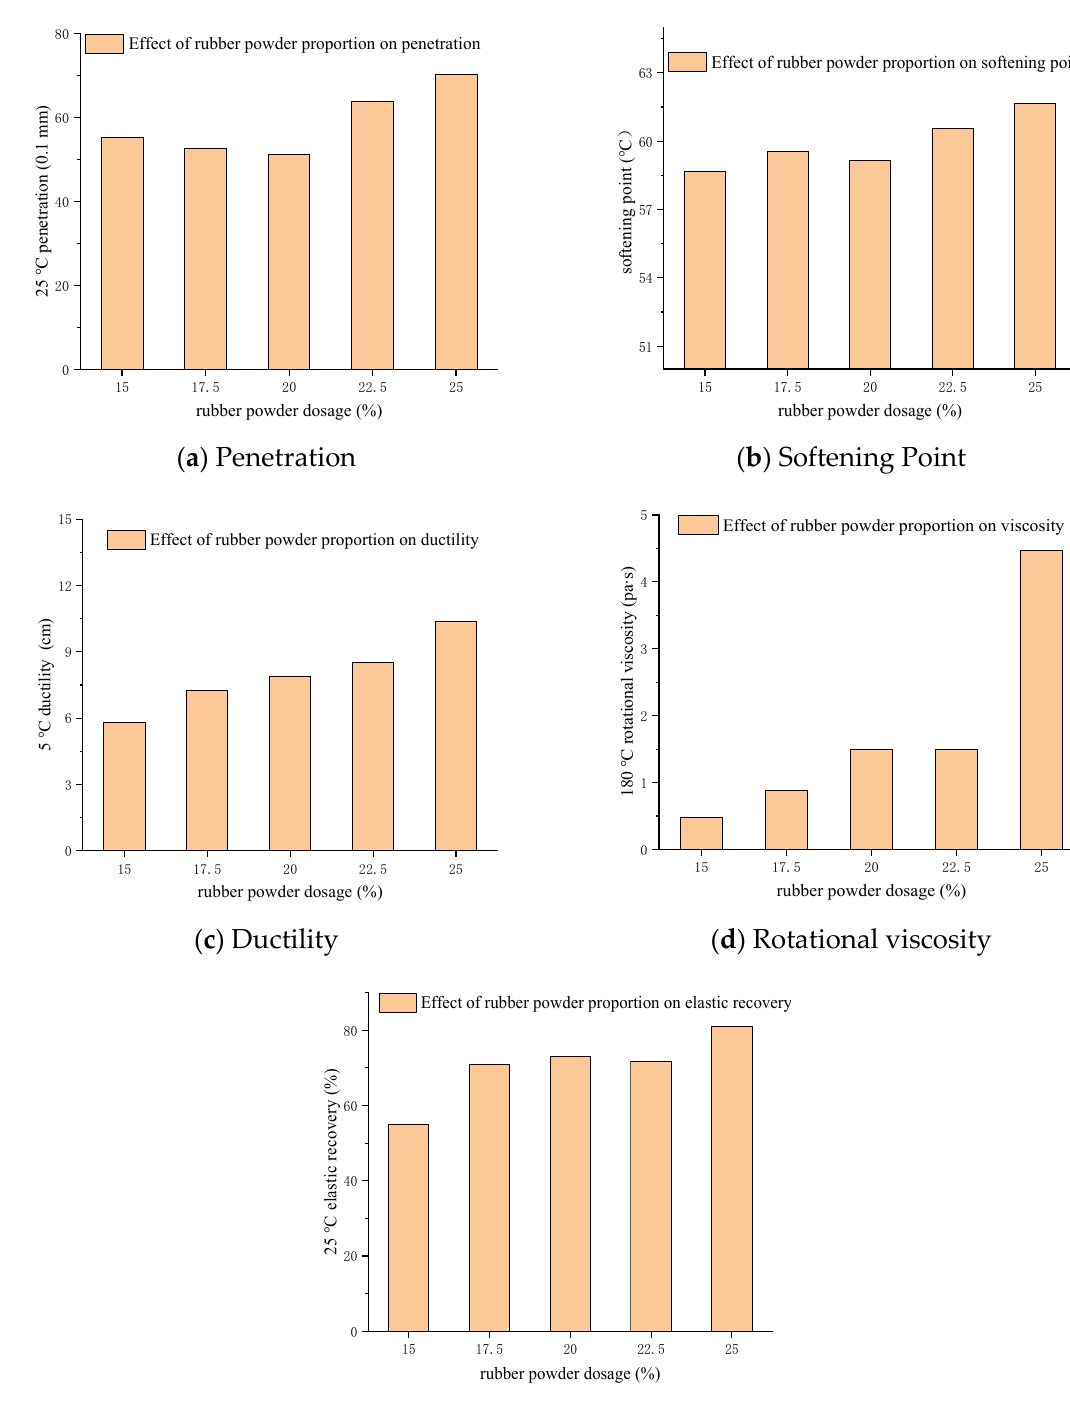
8 of 18 Table 6. Basic physical properties of different asphalt rubber (AR). Properties Proportion